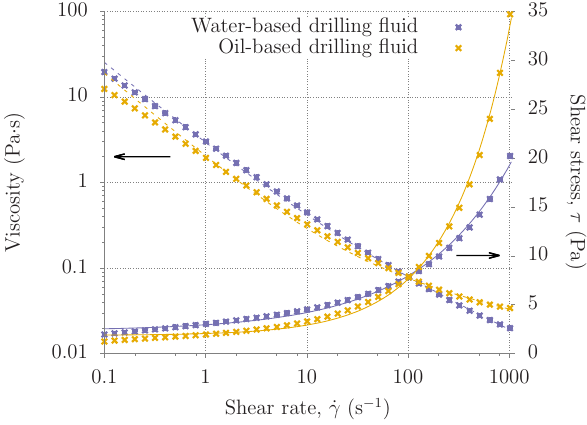
Figure 1: Steady state shear stresses and viscosities for the two drilling fluids. The solid lines are associated with shear stress mea- surements while dashed lines correspond to effective viscosities.